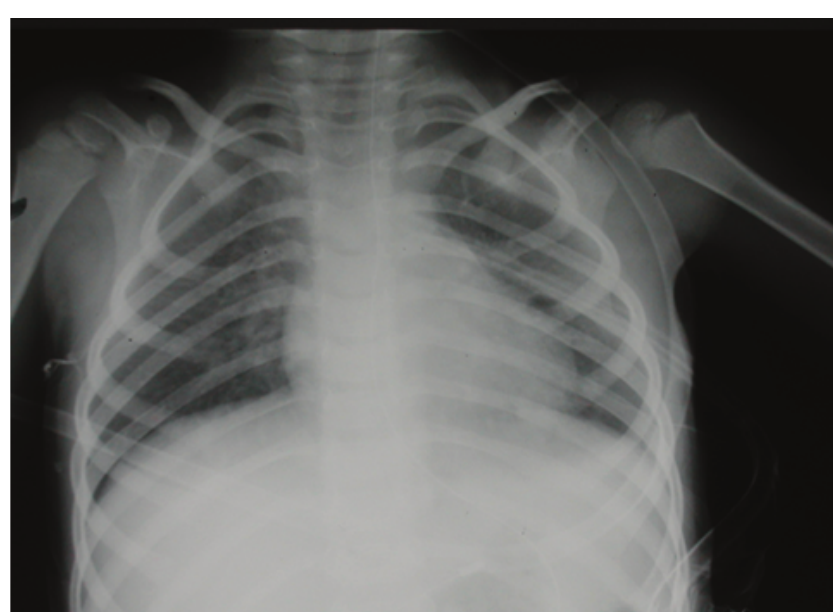
Figure 4: CXR after